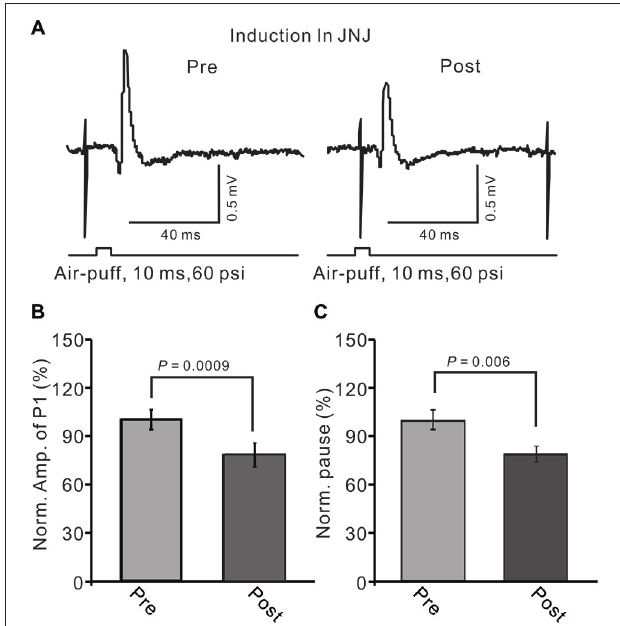
FIGURE 9 | Blocking N-methyl-D-aspartate (NMDA) receptors during 1 Hz stimulation abolished the LTD of GABAergic transmission at PCs . (A) Upper, representative cell-attached recording traces showing air-puff stimulation (10 ms, 60 psi)-evoked responses in a PC before (pre) and after (post) delivery of 1 Hz (240 pulses) stimulation delivered in the presence of NMDA receptor antagonist, D-APV (50 µ M). (B) Summary of data showing normalized amplitude of P1 before (pre) and after (post) delivery of 1 Hz (240 pulses) stimulation. (C) Pooled data showing the normalized pause of SS firing before (pre) and after (post) delivery of 1 Hz (240 pulses)